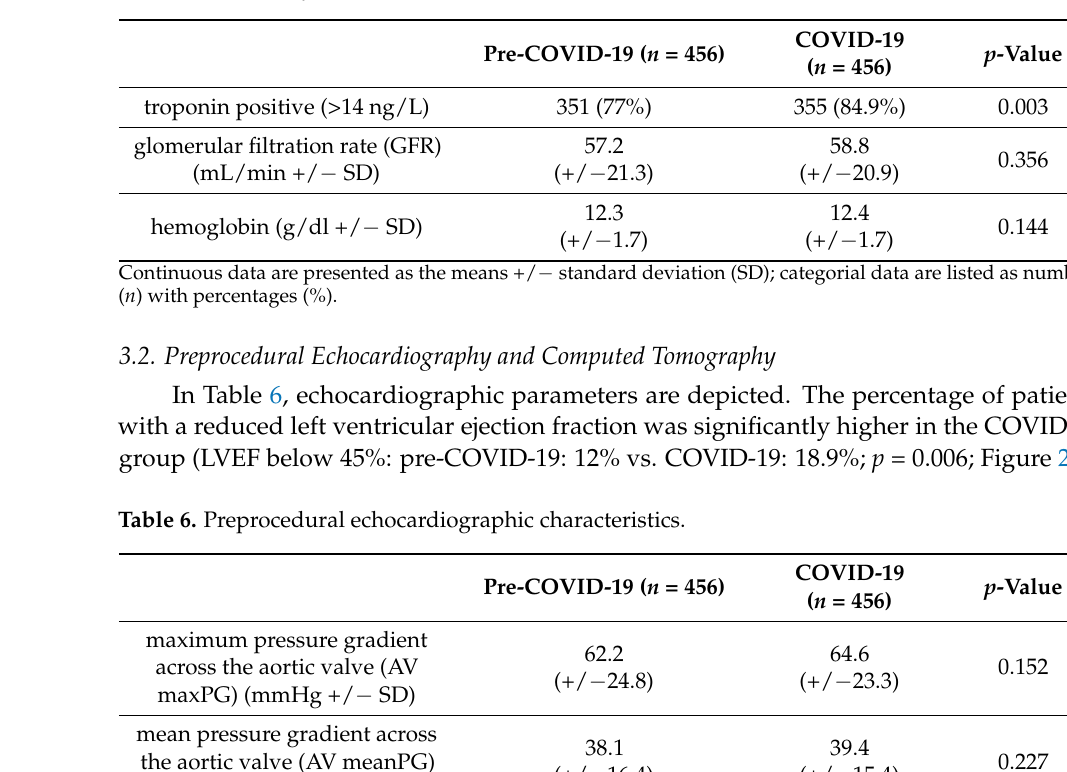
Table 5. Laboratory.